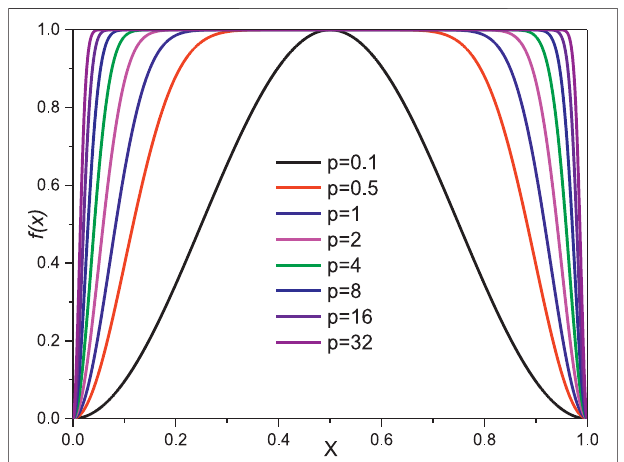
FIGURE 2 | Proposed window function versus state variable with various p .